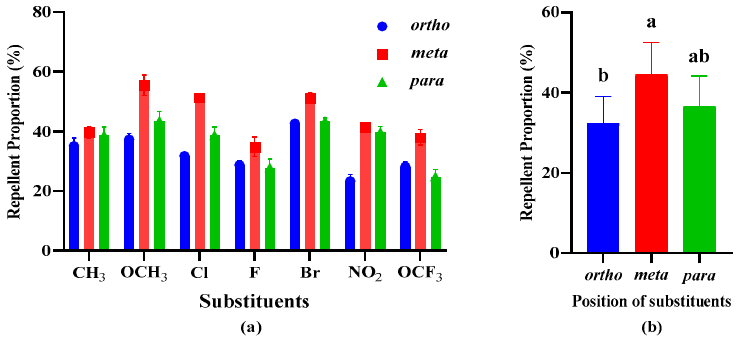
Figure 2. ( a ) The order of the repellency proportion of monosubstituents against A. pisum ; ( b ) The positional effects of ortho- , meta- , and para- substituents on repellent activity. Data represent the mean ± standard deviation. A one-way analysis of variance (ANOVA) was performed followed by